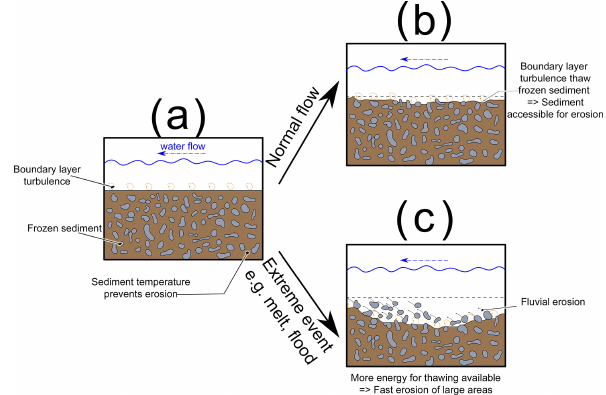
Figure 12. Proposed thermo-mechanical erosion mechanism at the bottom of subglacial channels of cold-based glaciers. (a) Temper- atures below freezing prevent the water from eroding material in case of low flow. (b) During summer and normal flow rates bound- ary layer turbulence thaws the surface layer of the sediment and ex- poses it to mechanical erosion. (c) Exceptional high flow velocities and available thermal energy cause a rapid sediment thaw, expos- ing larger areas of the ground to mechanical erosion, and clasts get transported away due to high flow velocities, leading to high erosion